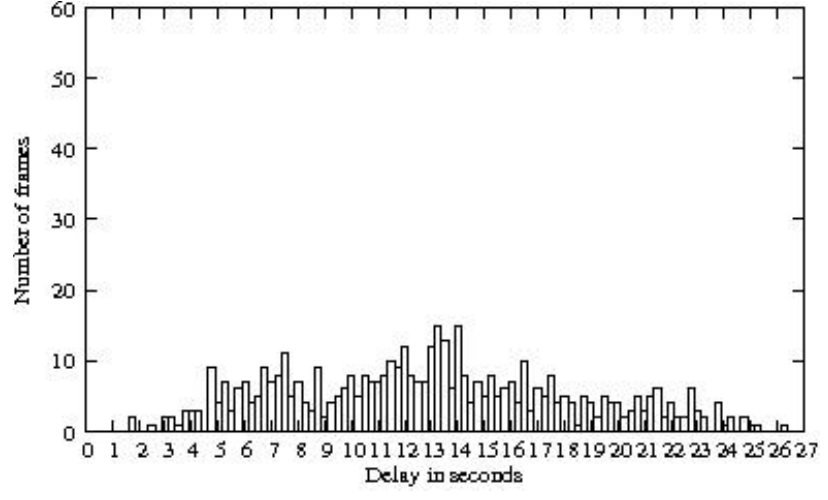
Figure 9. End-to-end delays for general traffic obtained with a general